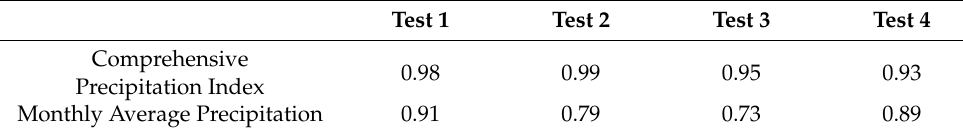
Table 2. Accuracy of the test sets using two different